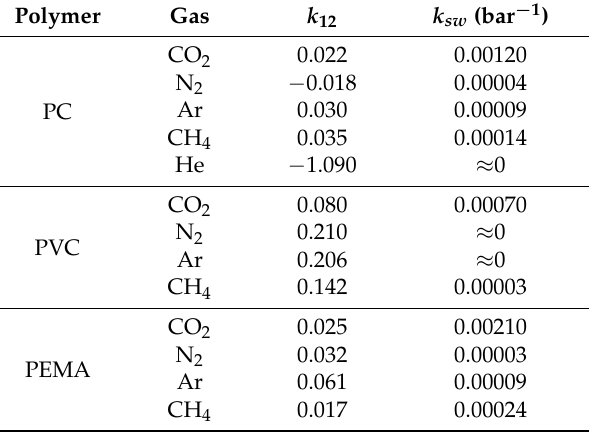
Table 2. Binary interaction parameters k 12 for the Sanchez and Lacombe EoS and nonequilibrium swelling coefficients k sw calculated by the approach by Minelli and Doghieri [48], to be used in the NELF model calculations